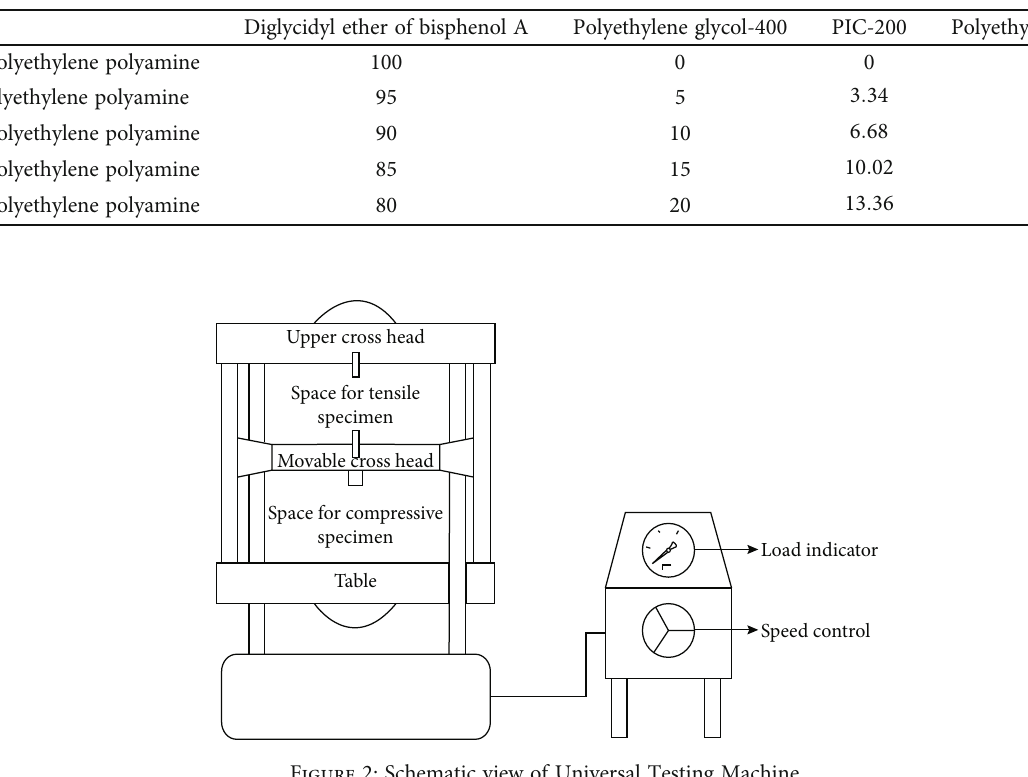
Table 1: Masses of di ff erent compositions of polyethylene polyamine.